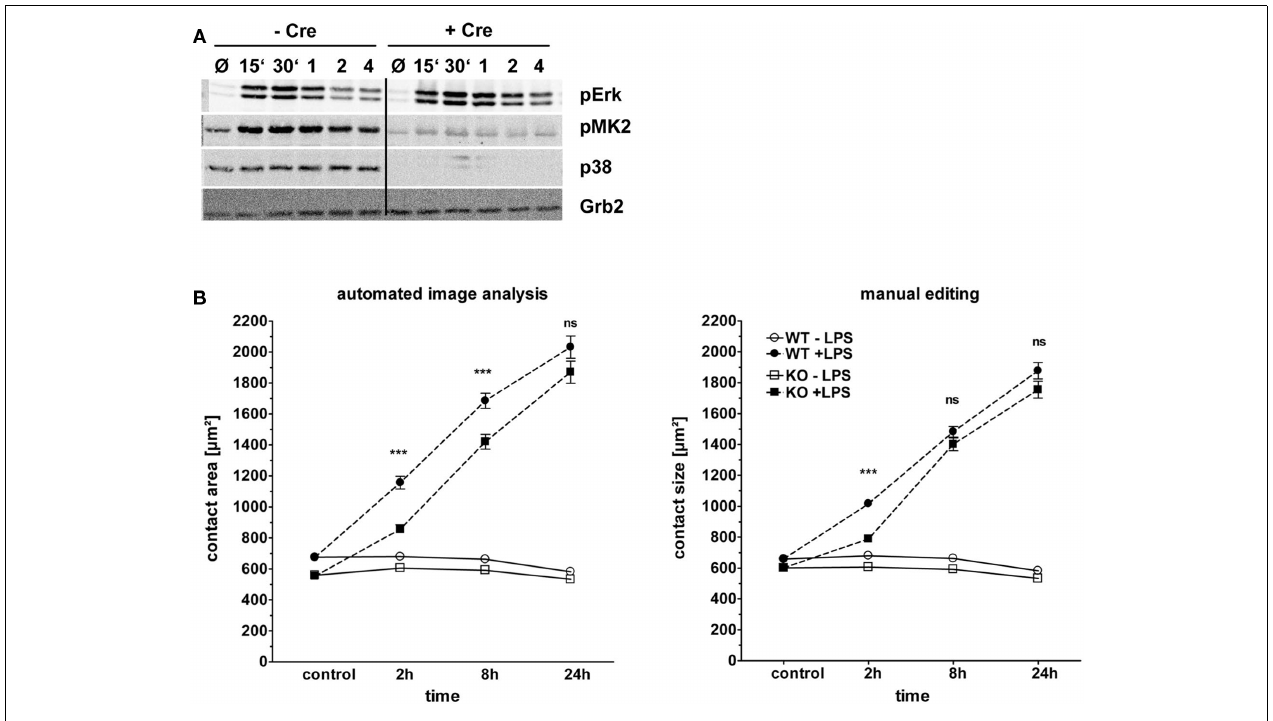
control. (B) Macrophage spreading kinetics of Cre + (KO, squares) and Cre − (WT, circles) BMM stimulated with LPS (closed symbols) or media control (open symbols). Results of automated image analysis (left panel) and manual editing (right panel). Statistical significance refers to the comparison of p38-deficient versusWT macrophages. ns = not significant; *** p <